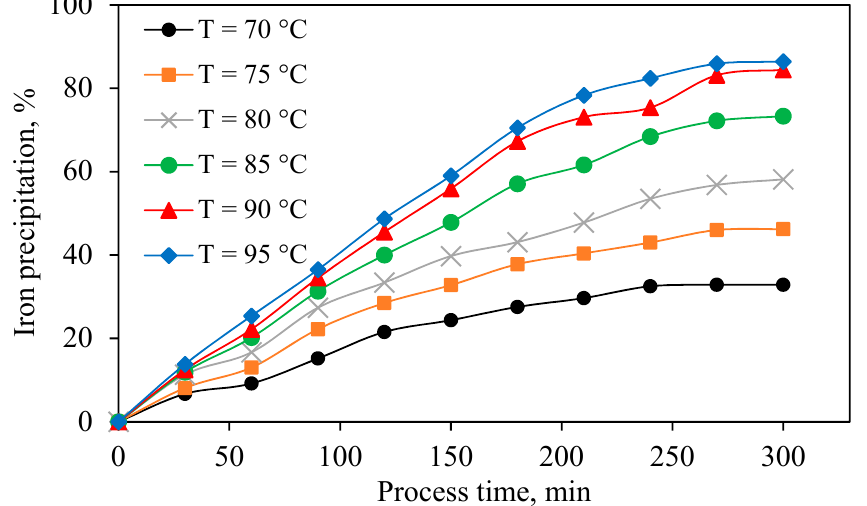
Figure 5. Effect of temperature on iron precipitation (Constant pH = 1, [Na 2 SO 4 ] = 2 g/L, stirring speed Figure 5. E ff ect of temperature on iron precipitation (Constant pH = 1, [Na 2 SO 4 ] = 2 g / L, stirring speed = 600 = 600 RPM).